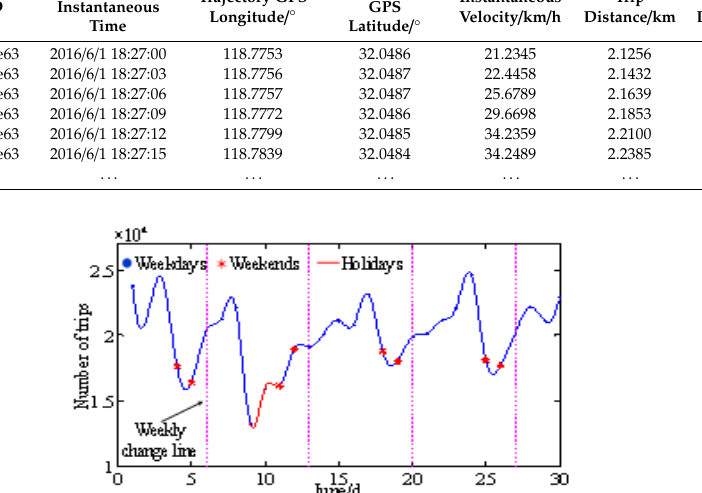
Figure A1. Display of the quantity of Didi online car-hailing trips in June.